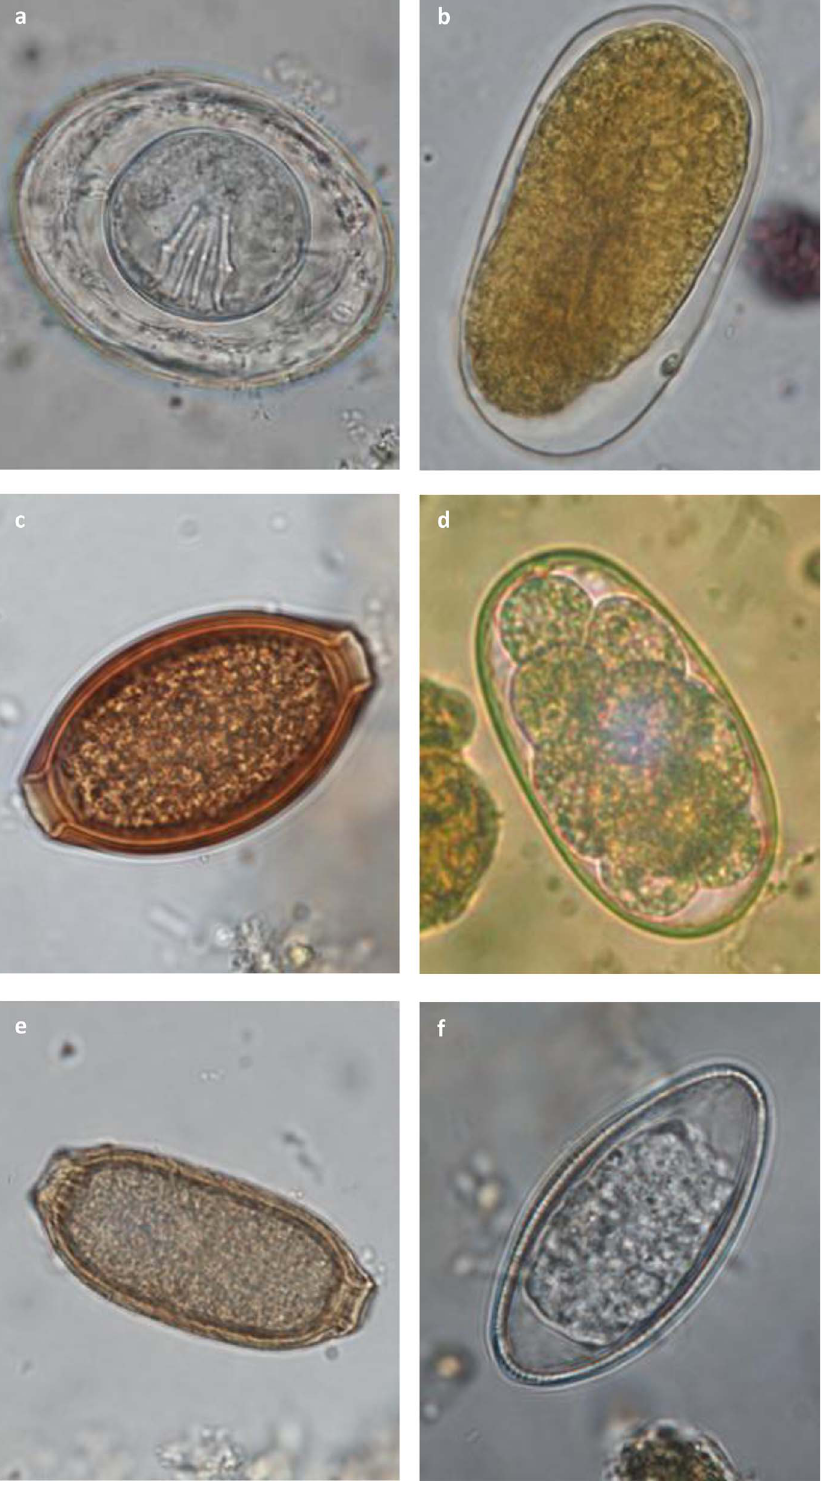
Figure 6. Diagnostic atlas for the identi fi cation of helminthic eggs in non-human primates. (a) Hymenolepis nana egg ( (cid:1) 100): round to oval of 30 – 50 l m in diameter containing an hexacanth embryo with equatorial polar fi laments; (b) Strongyloides sp. egg ( (cid:1) 100): oval, symmetrical of 40 – 70 l m by 20 – 35 l m with a thin membrane and parallel lateral sides; larvae can be present inside the egg; (c) Trichurid egg ( (cid:1) 100): oval, symmetrical of 50 – 80 l m by 20 – 40 l m with a smooth outer membrane and polar plugs striated perpendicular to the axis of the egg; (d) Strongylid egg ( (cid:1) 100): oval of variable size with a thick outer membrane, asymmetrical lateral sides and containing a morula; (e) Capillariid egg ( (cid:1) 100): oval, symmetrical of 50 – 80 l m by 20 – 40 l m with a smooth outer membrane and polar plugs striated parallel to the axis of the egg; (f) Oxyurid egg ( (cid:1) 100): oval, slightly asymmetrical of 50 – 60 l m by 20 – 30 l m with one fl at lateral side, a thick outer membrane and a vermiform